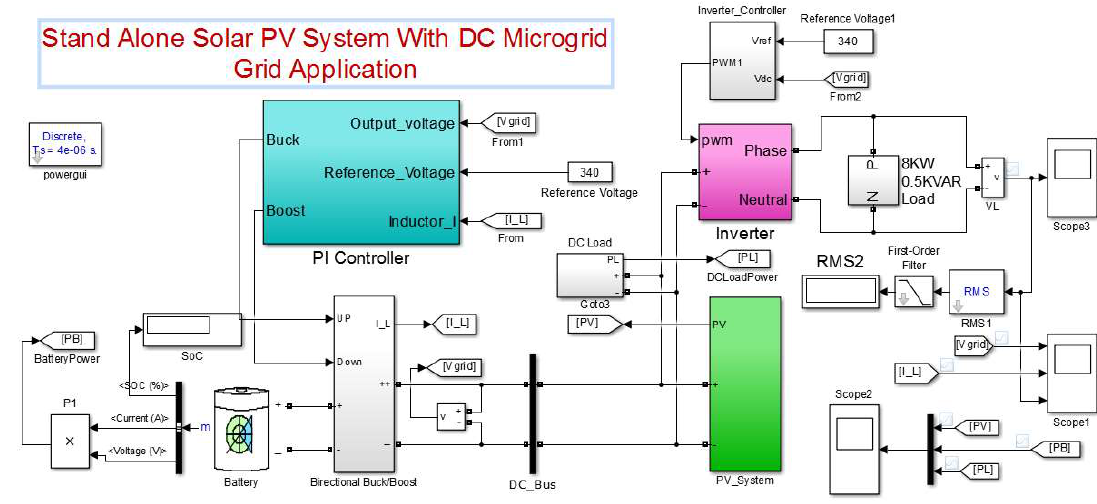
Figure 4. The complete model of the proposed system.